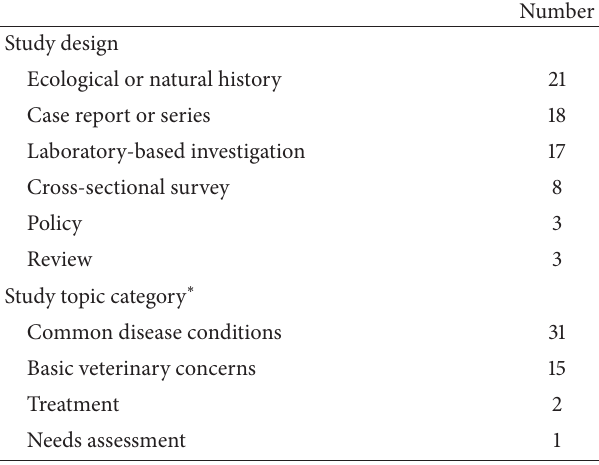
Table 1: Study designs and topic categories that characterize elephant studies conducted in Asia that were identified in a PubMed